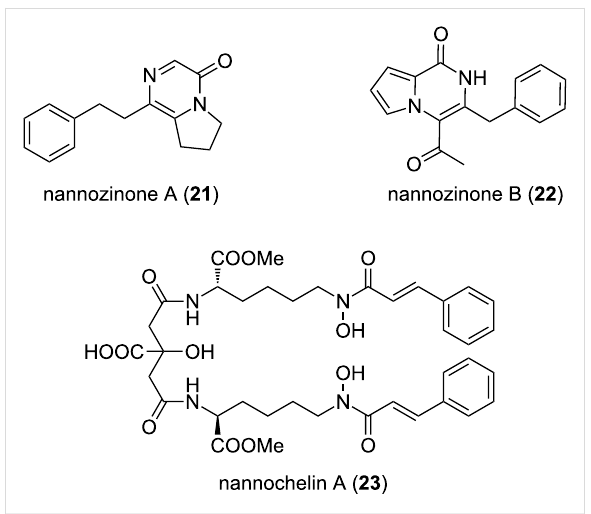
B ( 16 ), synthesized by Ari7, additionally include an α -pyrone moiety [48].